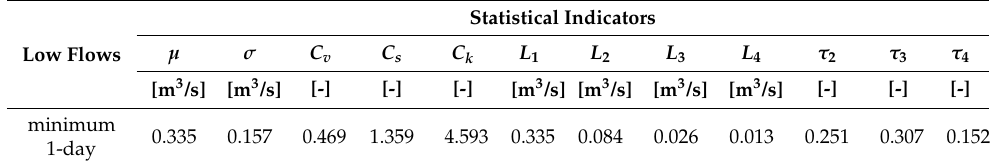
Table 4. The statistical indicators of the data series.